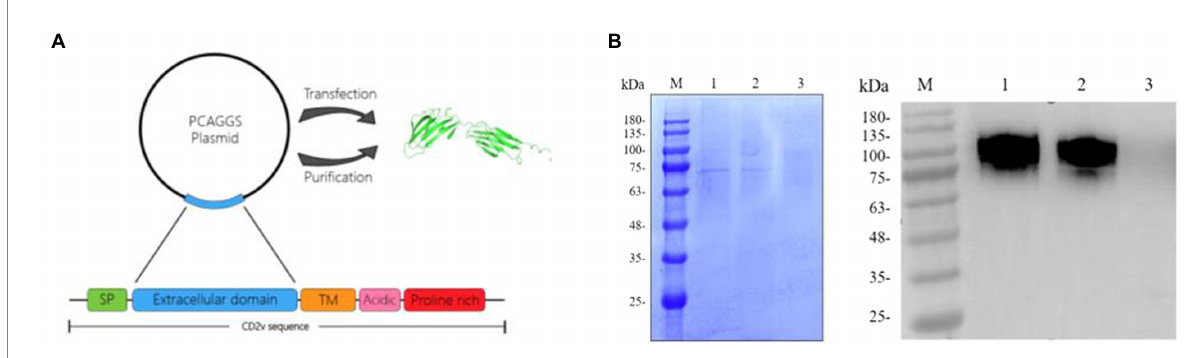
FIGURE 3 Preparation and purification of recombinant CD2v protein. (A) Preparation of the recombinant protein. The recombinant CD2v protein was sequenced to select the extracellular domain of the CD2v protein. The extracellular domain of the CD2v gene was ligated to the PCAGGS vector and transfected into 293F cells to express the recombinant protein. The protein structure diagram in the figure was predicted by AlphaFlod2 software. (B) Purified and unpurified CD2v recombinant proteins were analyzed by sodium dodecyl sulfate–polyacrylamide gel electrophoresis (SDS–PAGE) and western blot (WB) analysis. M is the protein marker, Lane 1 was loaded with purified CD2v recombinant protein, and Lane 2 was loaded with 293F cell culture medium before purification. Lane 3 was loaded with normal 293F cell culture medium (Control). The molecular weight of the recombinant protein is approximately 75–100